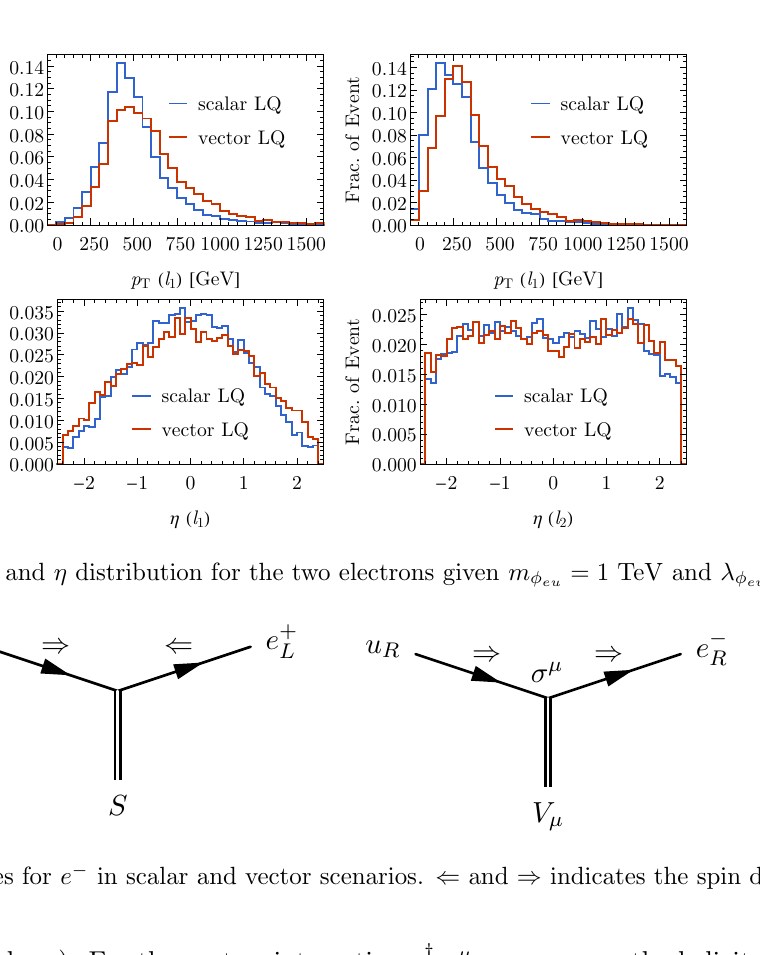
Figure 5. Vertices for e (cid:0) in scalar and vector scenarios. ( and ) indicates the spin directions. harder than the gluon). For the vector, interaction e y (cid:27) (cid:22) u R preserves the helicity R